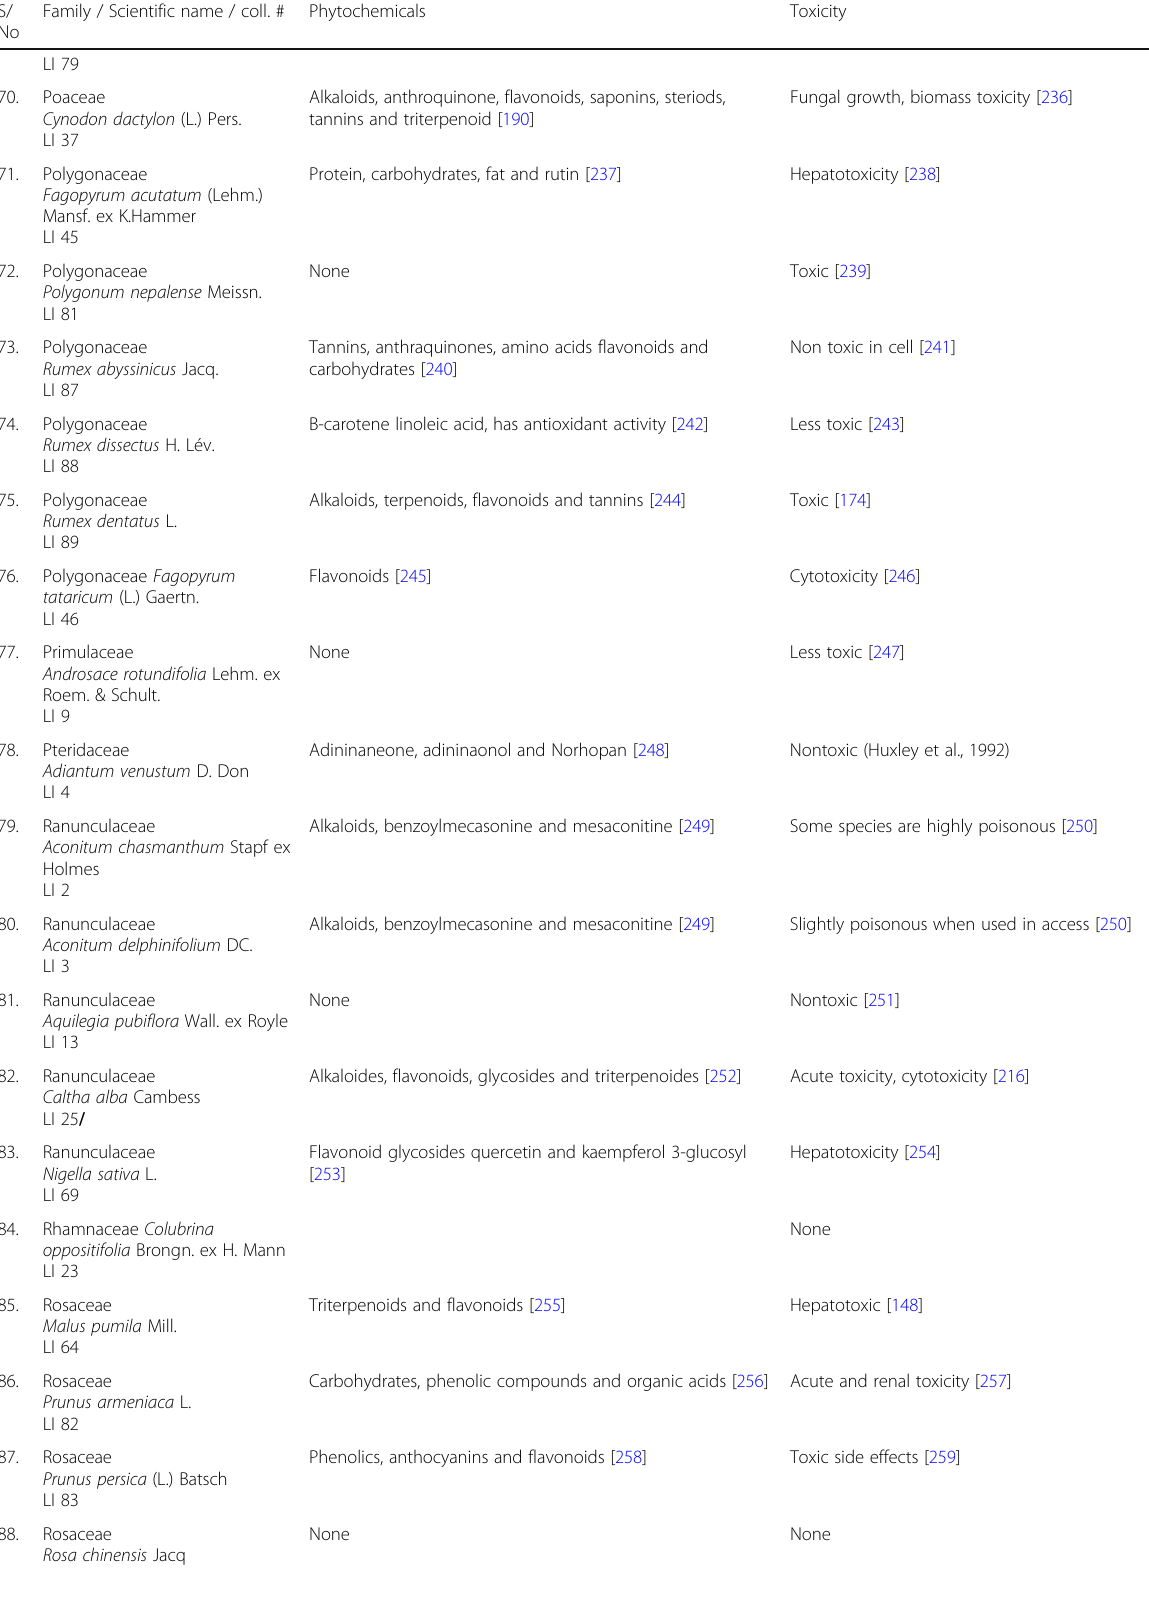
Table 5 Phytochemical activities and toxicity of medicinal plants used for skin diseases (Continued) S/ Family / Scientific name / coll. # No